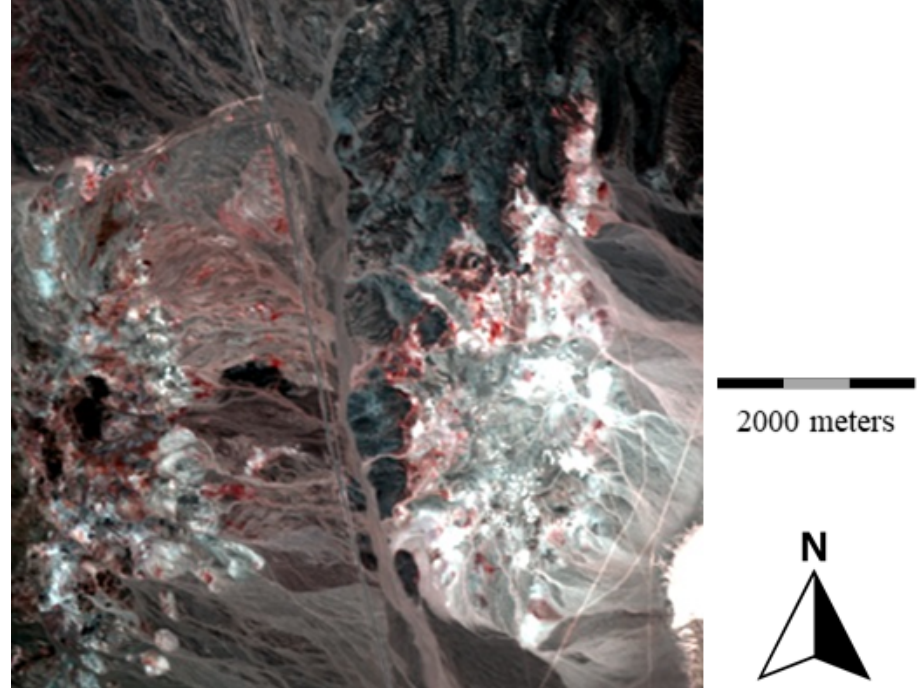
Figure 5. Cuprite hyperspectral image (False color composition, with the 33rd, 15th, and 11th spectral bands for the red, green and blue layers,